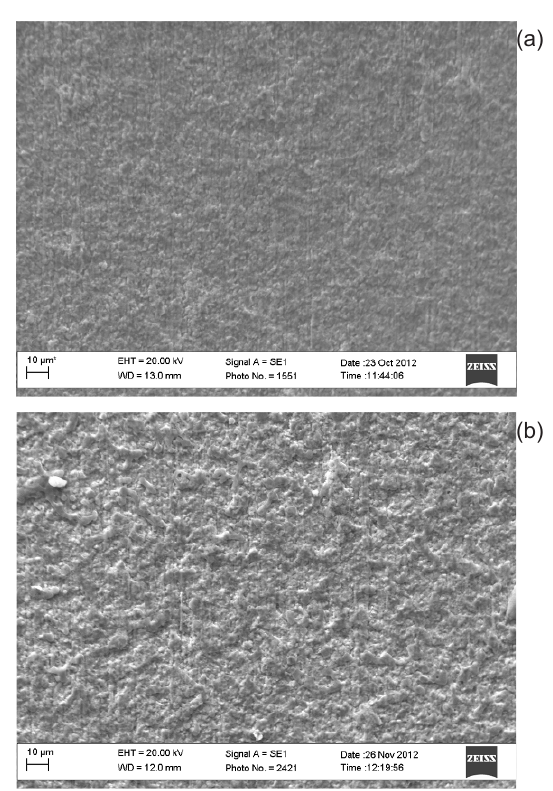
Figure 4. Surface morphology of Ti-6Al-4V alloy after nitriding (a); low-temperature oxidation of nitride coating based on Ti N phase (b) resulting from potentiodynamic 2 polarization in 0.9% NaCl at 40 o C.